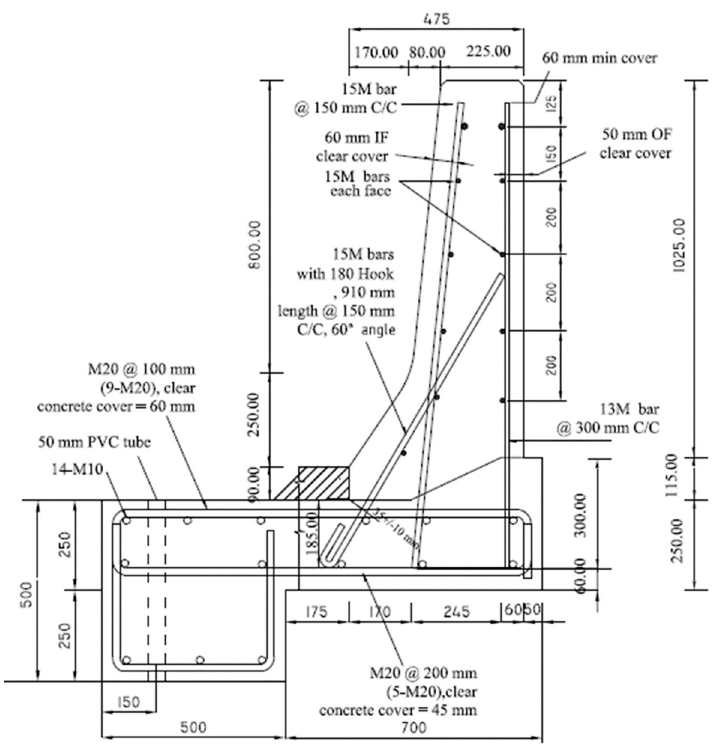
Materials 2019 , 12 , x FOR PEER REVIEW Figure 5. Specimen # 3: End location of barrier connected to a cantilever slab.